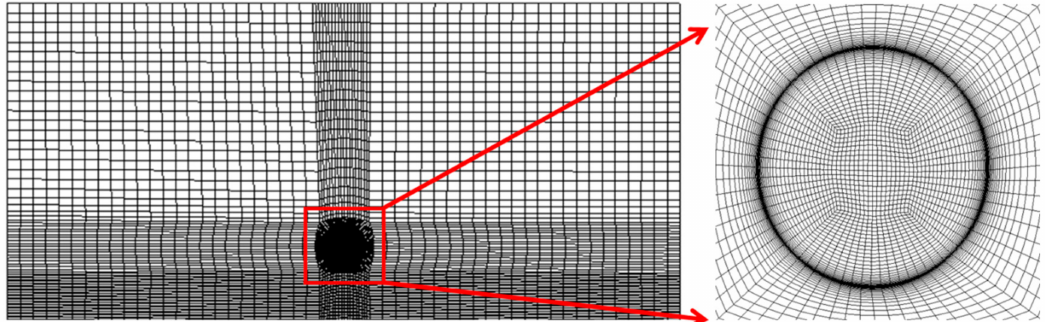
Figure 3. Mesh at the jet domain